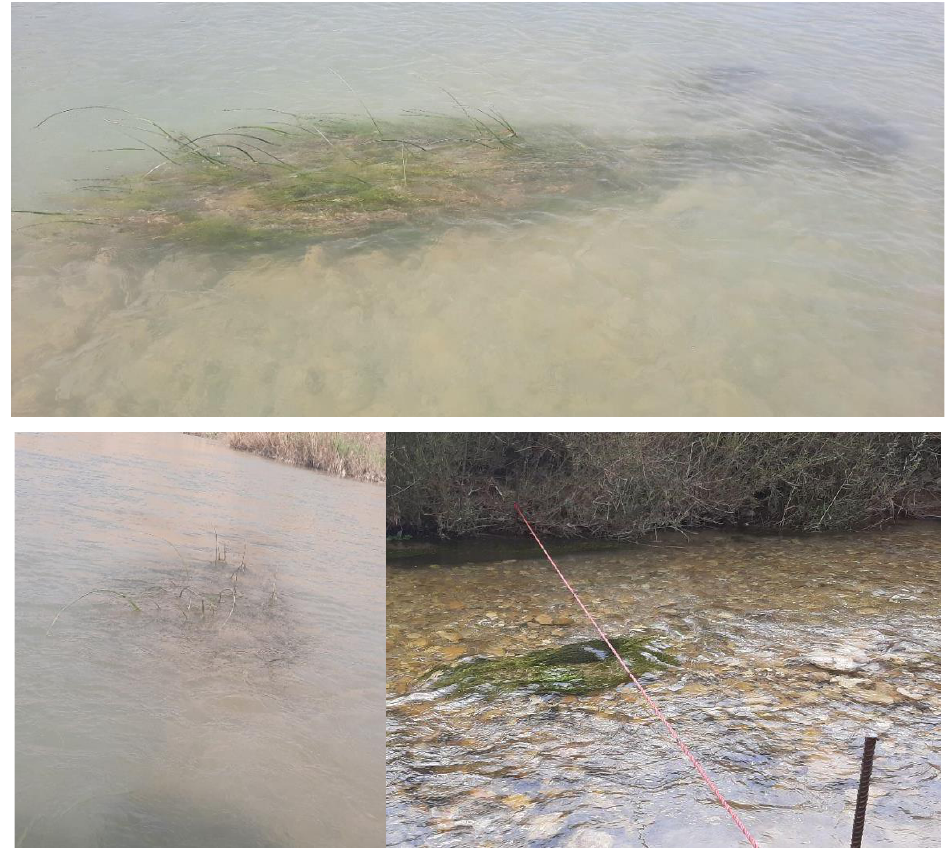
Figure 2. Some vegetation patches in selected reaches. Table 2. Vegetation patches’ characteristics of the reaches.